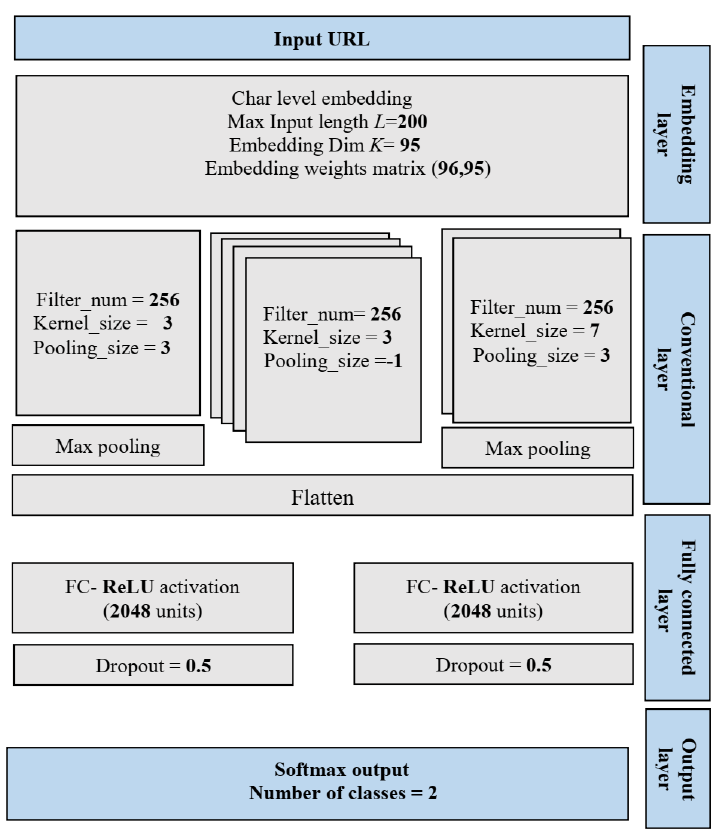
Figure 7. Configuration of the convolutional neural network